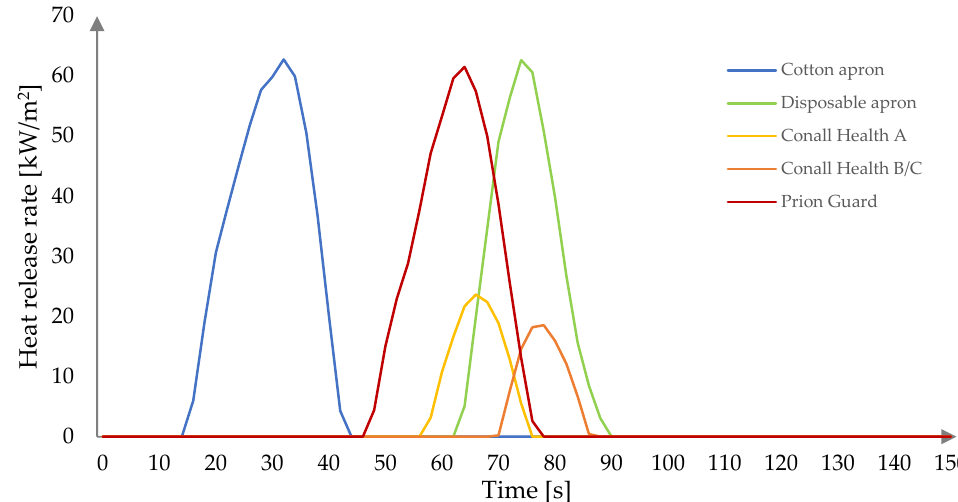
Figure 1. Heat release rate of studied fabrics at heat flux of 25 kW/m 2 .